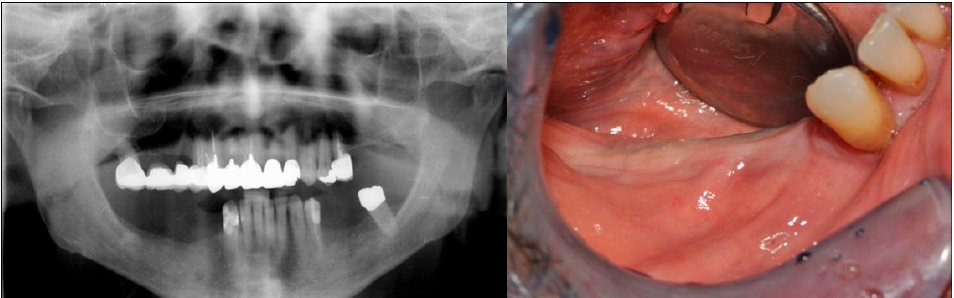
Figure 1. Pre-operative panoramic radiography and intraoral examination. The patient was missing from teeth 4.4 to 4.8.